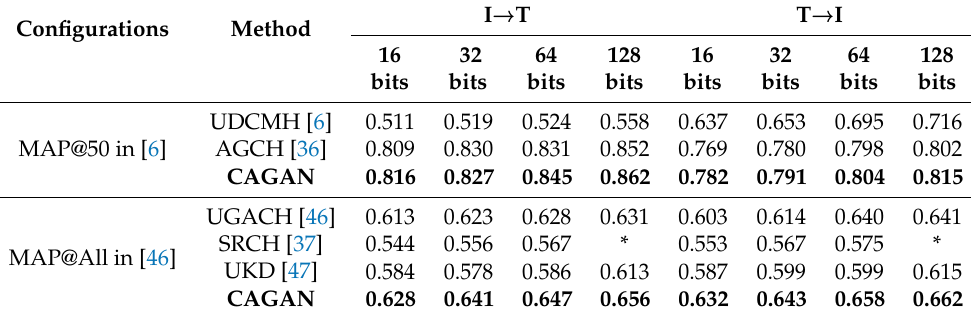
Table 4. The MAP comparison results with extra methods on the NUS-WIDE dataset.